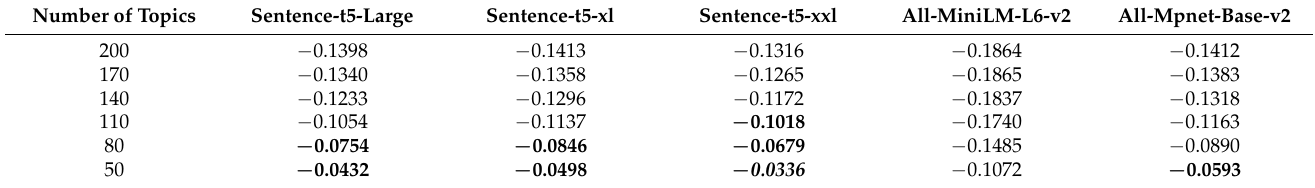
Table 9. Experimental results on sentence embeddings. Ranging from topic size 50 to 200